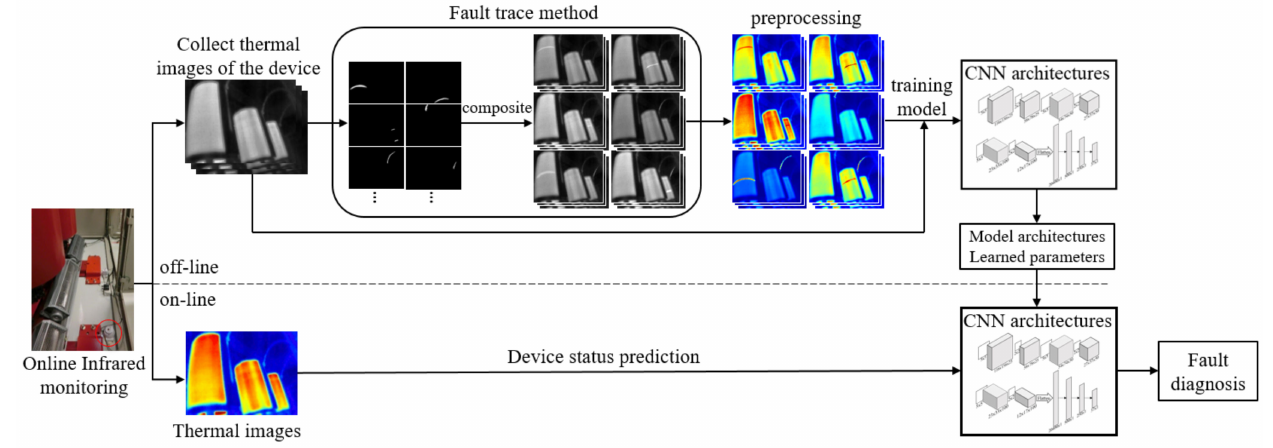
Figure 1. Flow chart of the fault overlay method of fault diagnosis.